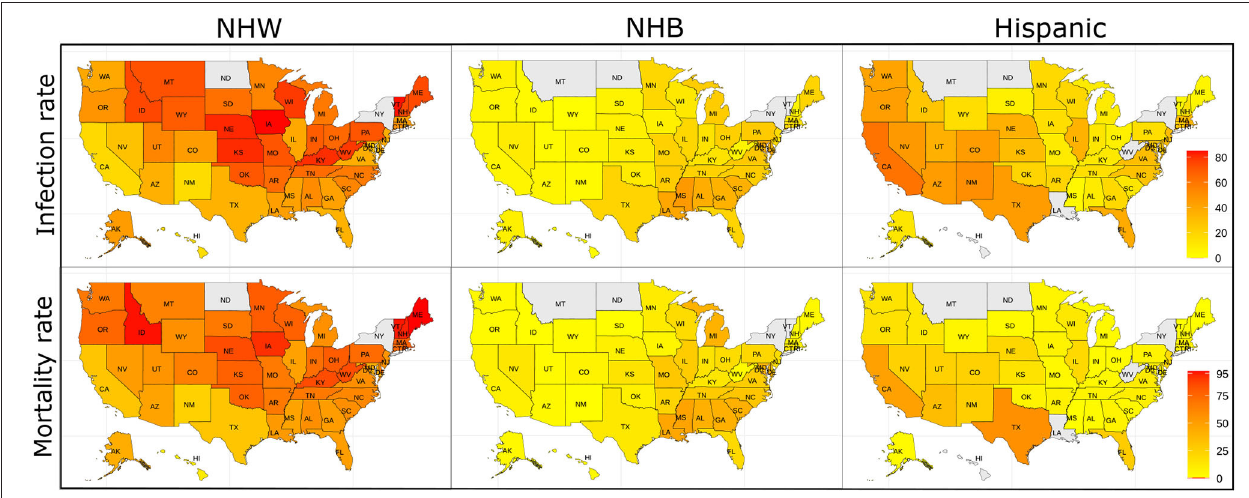
FIGURE 1 | The relative infection % and relative mortality % amongst the NHW, NHB, and Hispanic groups across the US. The states with no color indicate that the ethnicity-wise data on relative infection % and relative mortality % were not available in those